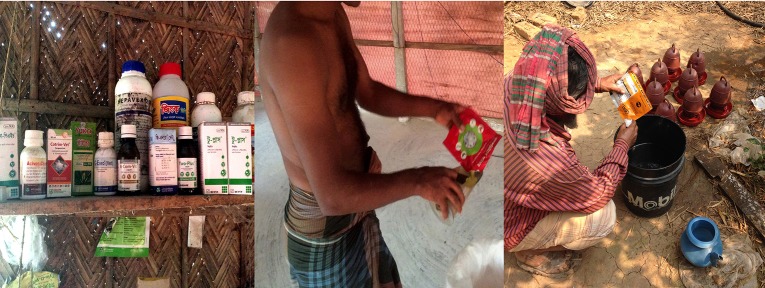
Application of antibiotics in poultry feed and drinking water.